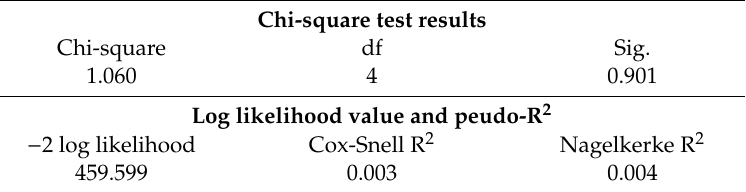
Table 8. Test results and log likelihood value and pseudo-R 2 for the model of the risk of inability to pay